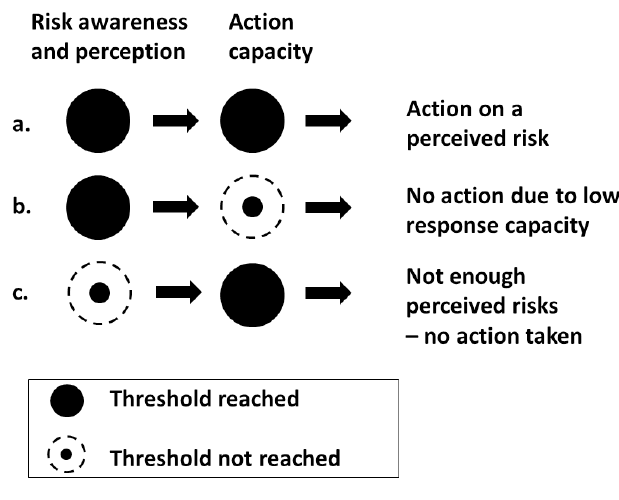
Fig. 2 . Two types of thresholds were identified from the empirical data relevant for the transition process in urban water services: (1) risk awareness and perception and (2) action capacity.